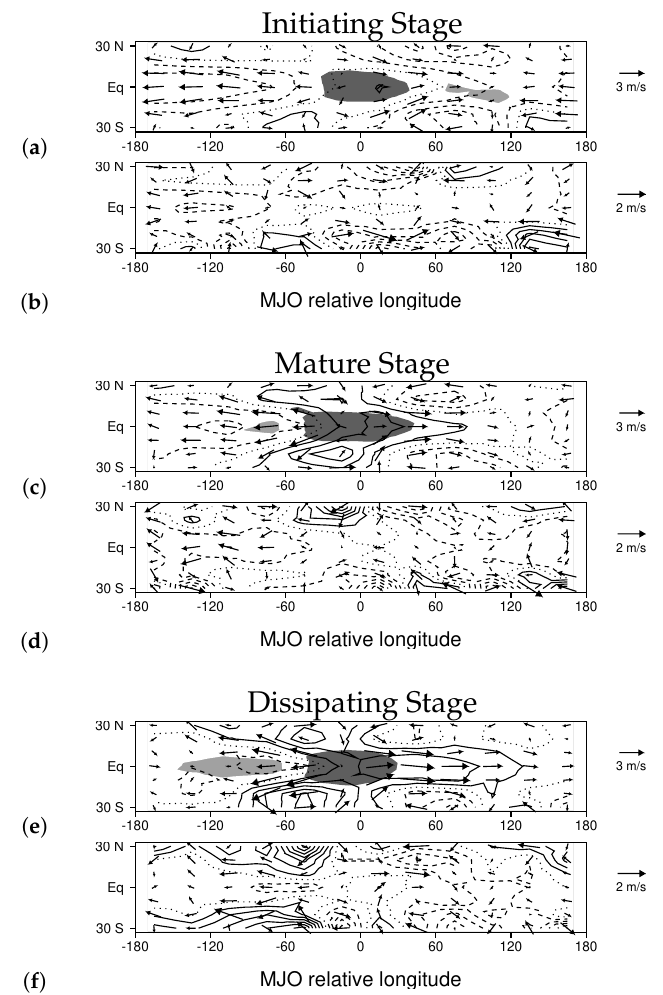
Figure 12. The change in the composite horizontal structure of the MJO during the coarse of the simulation. ( a , b ) Composite MJO average tropospheric temperature and upper level wind perturbations for the initiating stage for Years 71–100 and their difference from those for years 1–30. ( c , d ) Composite MJO average tropospheric temperature and upper level wind perturbations for the mature stage for Years 71–100 and their difference from those for years 1–30. ( e , f ) Composite MJO average tropospheric temperature and upper level wind perturbations for the dissipating stage for Years 71–100 and their difference from those for years 1–30. In each panel average troposphseric temperature is contoured with 0.1 K contour interval (zero dotted, negative dashed), and vectors illustrate 200 hPa